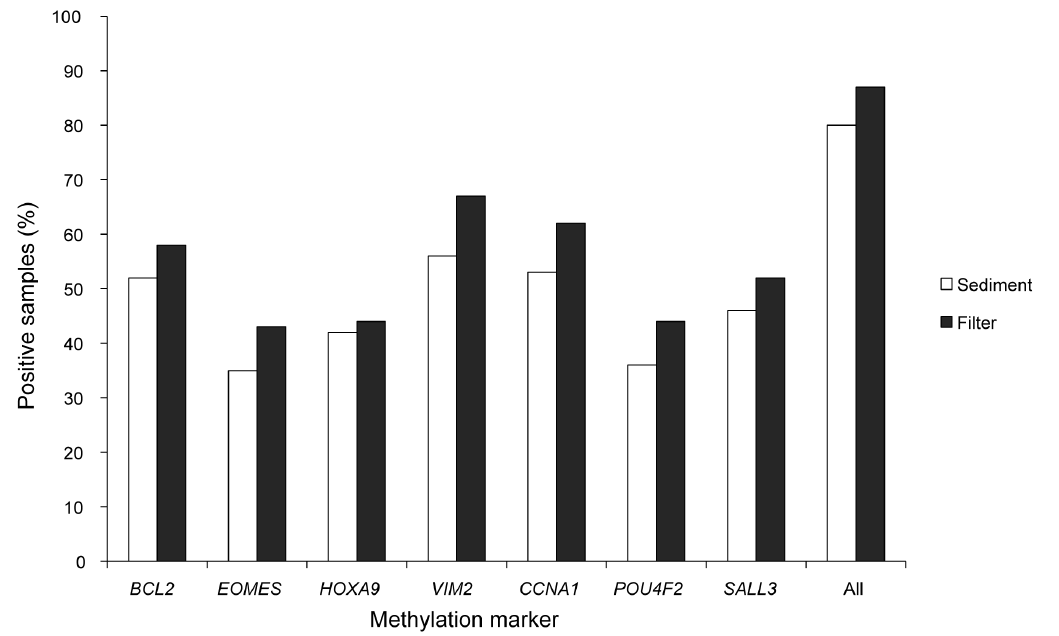
Figure 5. Sensitivity for detection of bladder cancer in paired sediment and filter samples (N=189). Shown are the percentages samples positive for the seven DNA-methylation markers. The last column (‘‘All’’) shows the percentage of samples positive for one or more markers.